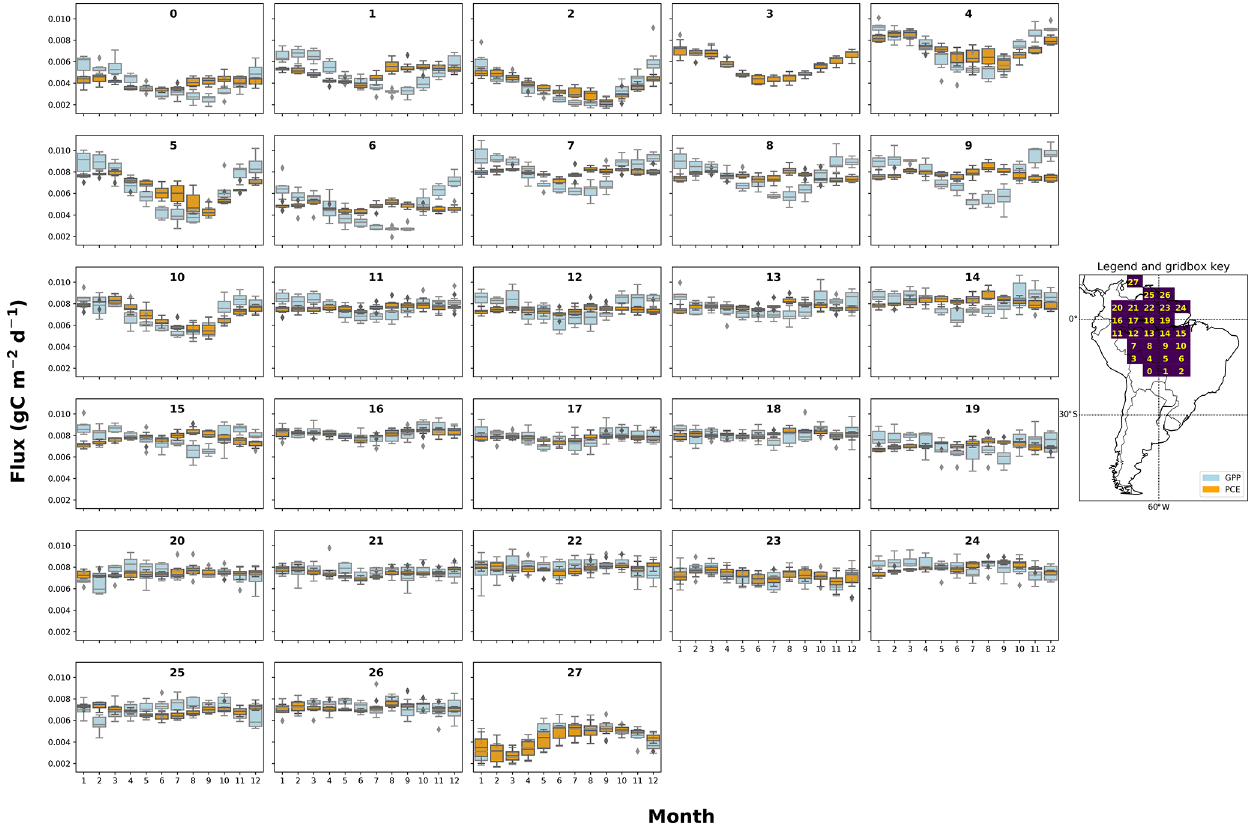
Figure A2. The mean seasonal trend of simulated plant carbon expenditure (PCE) and forcing gross primary productivity (GPP) (Parazoo et al., 2014) for each grid box in the f NSC = 0 . 08 SUGAR simulations. The map key shows which plot corresponds to which grid box.